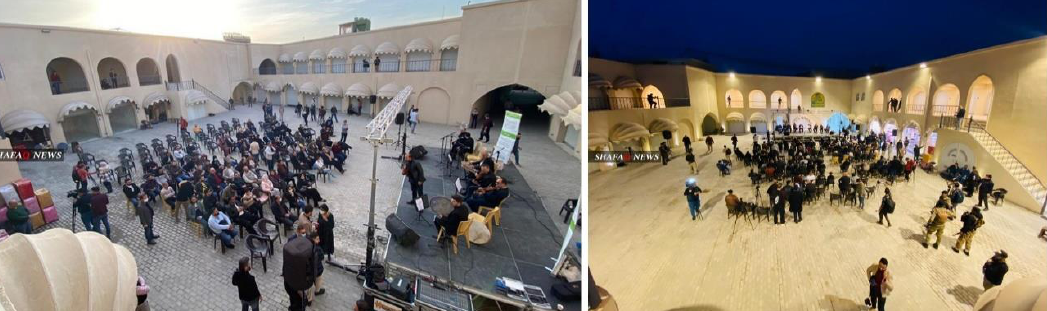
Figure 11. Preserving the Khan’s architectural style while using contemporary materials (photo credit: Nineveh Governorate and the Municipality of Mosul, Department of Media) [28].